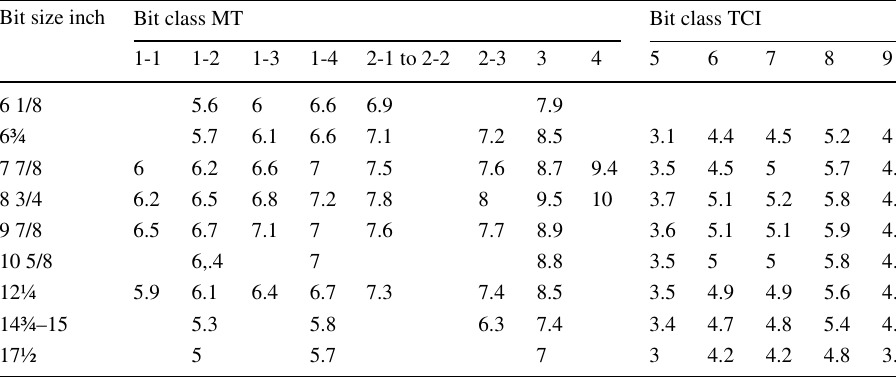
Maximum design weight on bit 1000 lb/in. (after